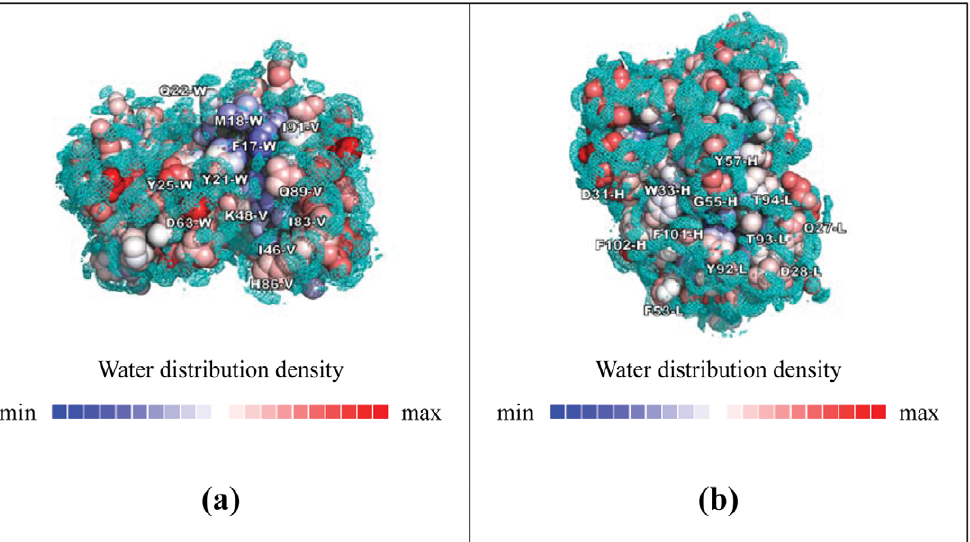
Figure 4. Hydration patterns on the surface of VEGF and the antibody. (a) Hydration patterns of VEGF are shown as the water oxygen atom PDM contours in cyan on the protein surface and as the color-coded atom surfaces. The water PDMs are shown as 0.0019 contours in this panel. The atom surfaces are color-coded according to the hydration pattern near the atom (Equation (3) in Text S1). (b) The hydration pattern for the G6-Fab (2FJG) is shown.